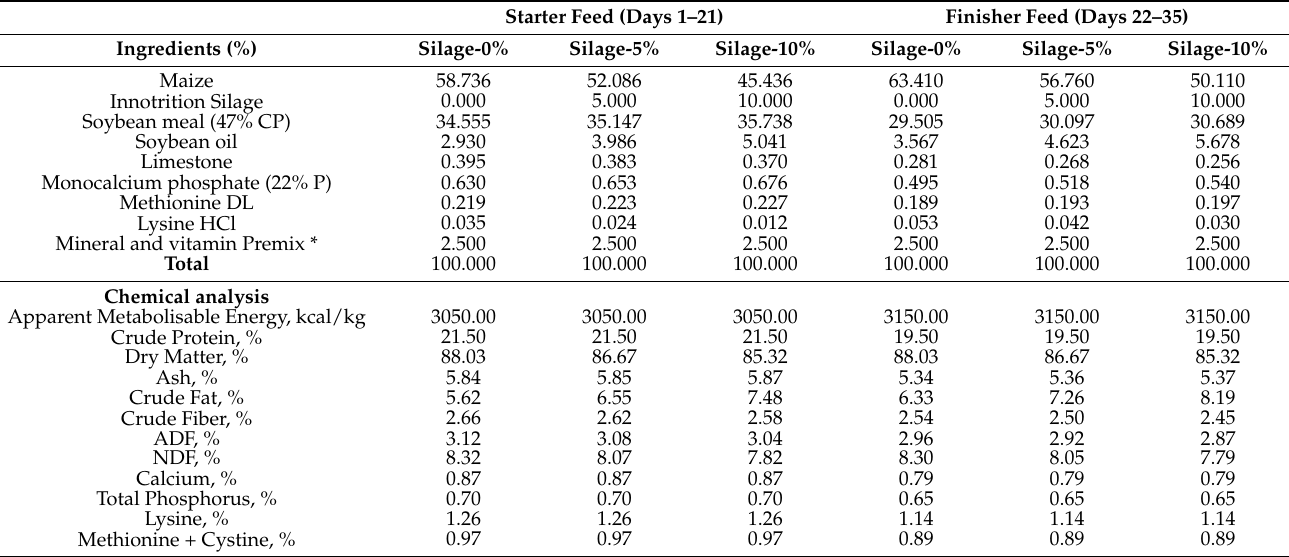
Table 2. Broiler chicken